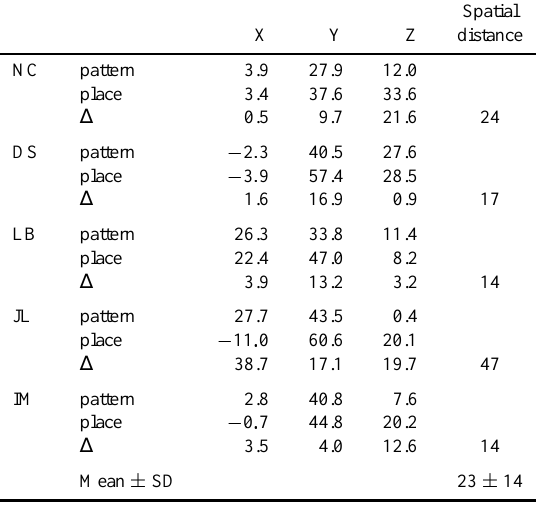
Table 1 Comparison of the locations of dipole 4, active during the CNV period, for the pattern and the place recognition tasks within each subject